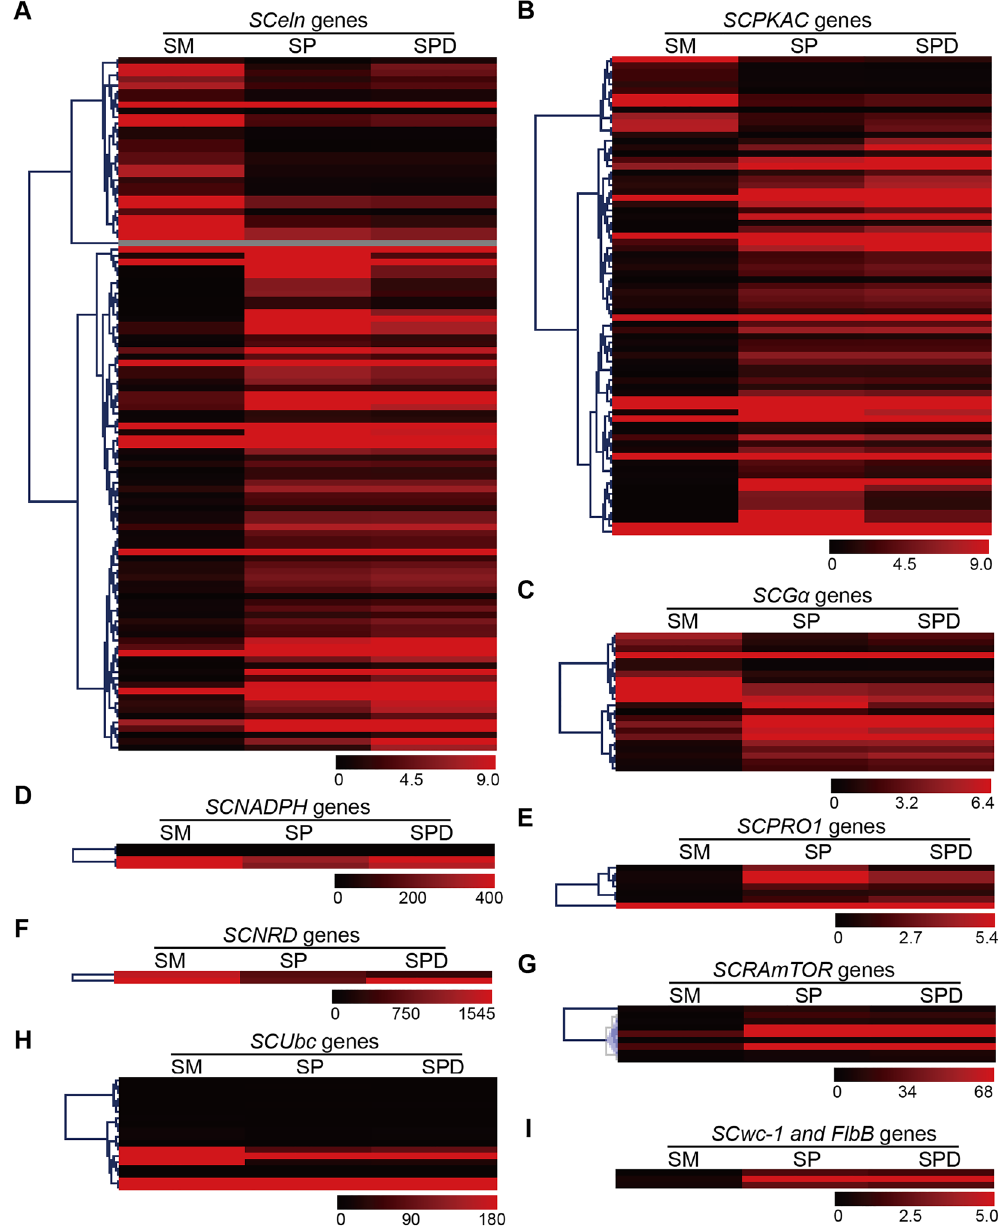
Figure 5. Heat map of important DEGs (differentially expressed genes) likely involved in fruiting formation. ( A ) SCelen genes; ( B ) SCPKAC genes; ( C ) SCGα genes; ( D ) SCNADPH genes; ( E ) SCPRO1 genes; ( F ) SCNRD genes; ( G ) SCRAmTOR genes; ( H ) SCUba genes; ( I ) SCwc-1 and FlbB